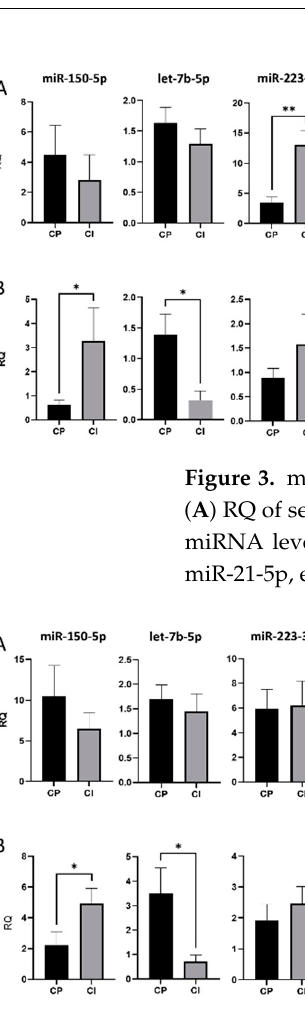
Figure 4. miRNA cargo in total and IB4-positive (IB4+) EVs in the Amsterdam MS Center cohort of MS patients. ( A ) RQ of selected miRNA levels in total plasma EVs from CP and CI patients. ( B ) RQ of selected miRNA levels in IB4+ EVs from CP and CI patients. Data were normalized to miR-16-5p and miR-451a, expressed as 2 – ΔΔ Ct . Mann–Whitney test, * p < 0.05.